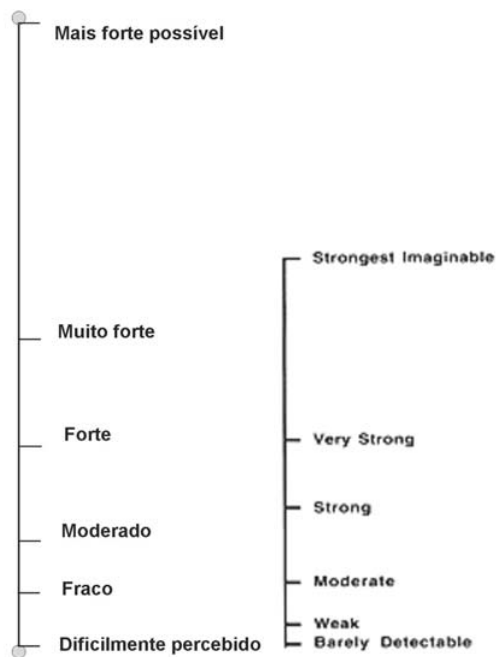
FIGURE 1- (LMS) Labeled measurement